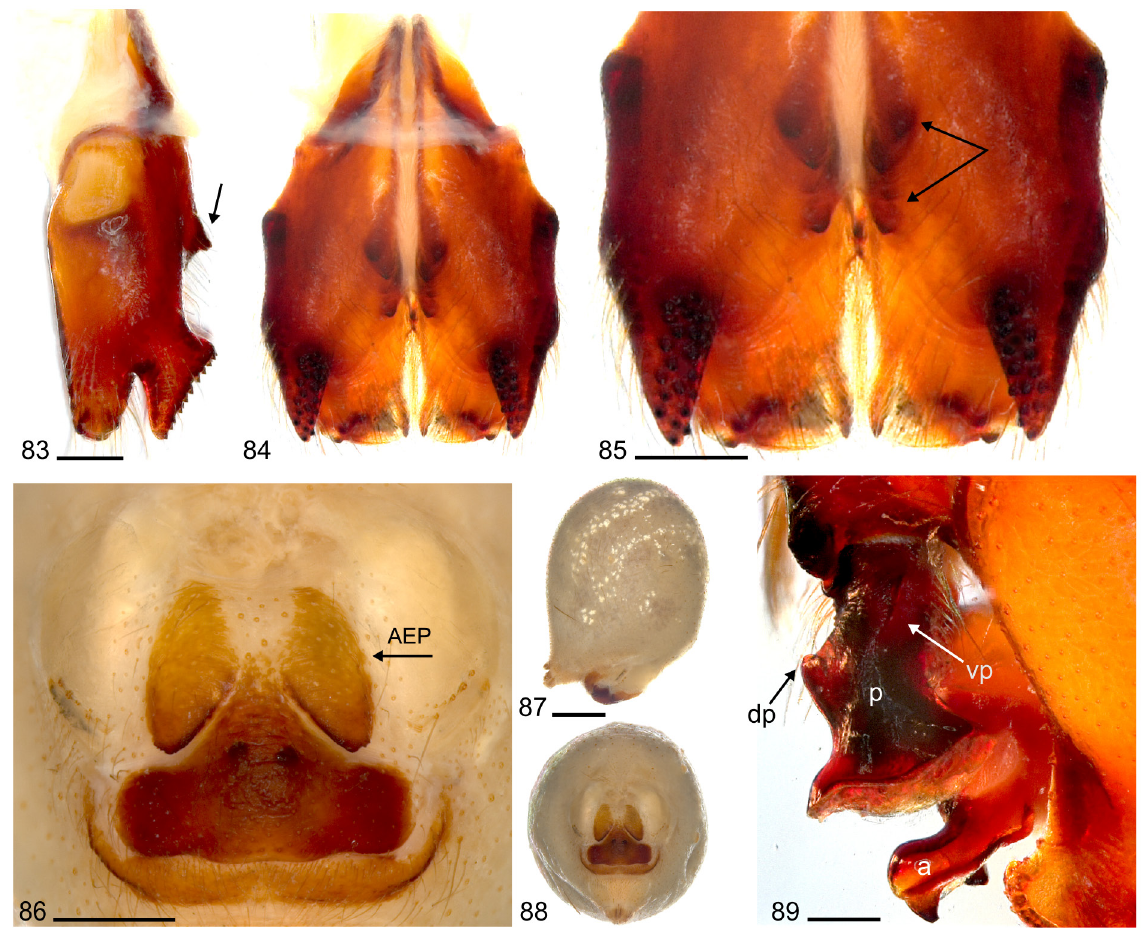
Figs 83–89. Artema kochi Kulczyński, 1901 (MNHN AR 10169 part, Yemen/Eritrea). 83–85 . Male chelicerae, lateral and frontal views (arrows: distinctive sclerotized processes frontally near median line). 86 . Epigynum and anterior epigynal projections (AEP). 87–88 . Female abdomen, lateral and ventral views. 89 . Procursus, showing ventral pocket (vp) and dorsal process (dp). Scale lines: 83–85, 89 = 0.25 mm; 86 = 0.5 mm; 87–88 =